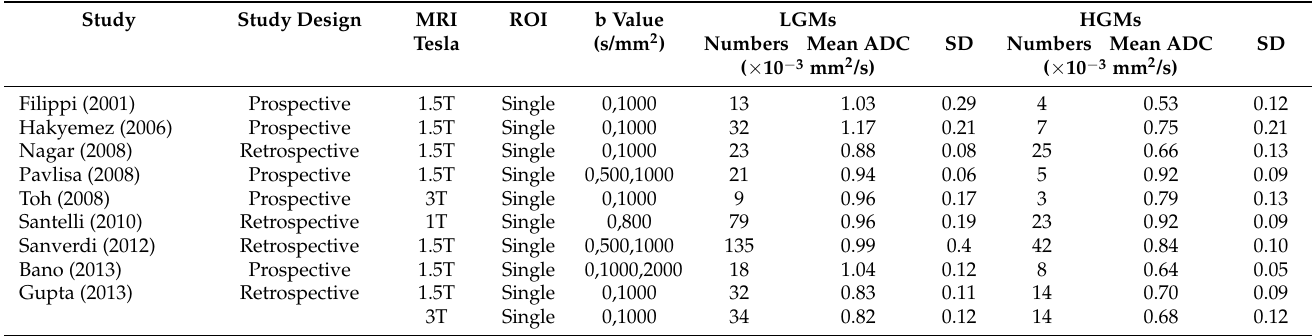
Table 1. Baseline characteristics of the 25 studies included in the